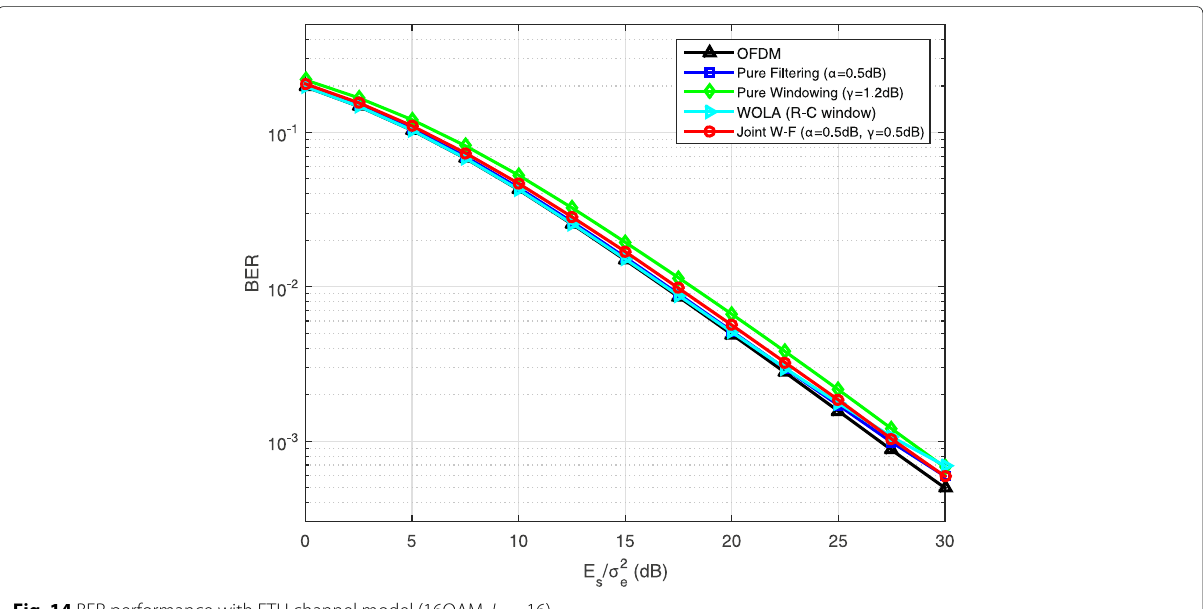
Fig. 14 BER performance with ETU channel model (16QAM, L = 16)